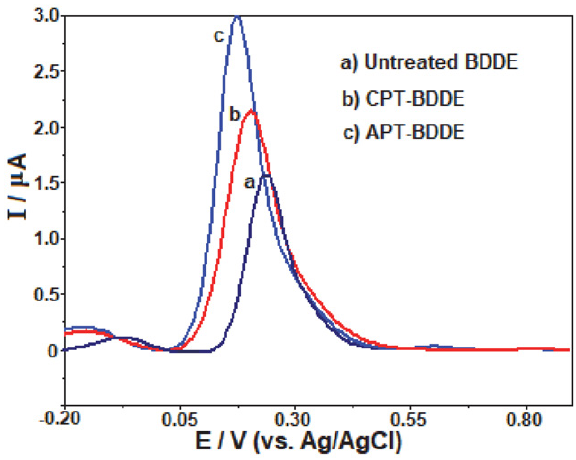
Figure 3. SW voltammograms of 0.1 mM lawsone solutions ob- tained at untreated (a) and cathodically (b) or anodically (c) or pre-treated BDD electrode in 0.1 M phosphate buffer (pH 2.5) solu- tion. SWV parameters: frequency, 50 Hz; step potential, 8 mV; pulse amplitude, 30 mV.